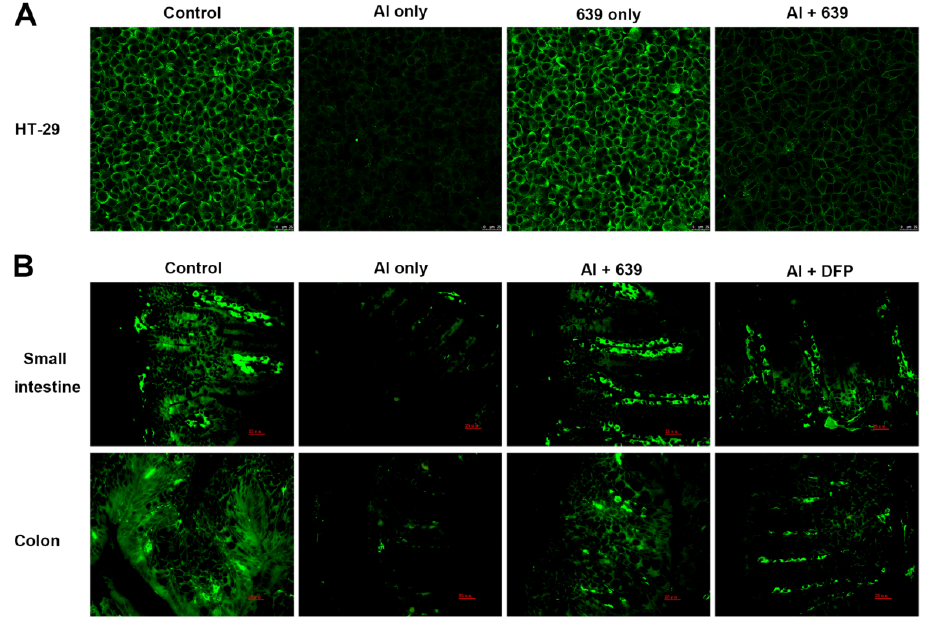
Figure 1. Effects of L. plantarum CCFM639 on Al ‐ induced alterations of tight junction protein ZO ‐ 1: in vitro ( A ); and in vivo ( B ). The ZO ‐ 1 levels in HT ‐ 29 cell (therapy assay) and intestine of mice (intervention assay) were observed with confocal microscopy and stained by Alexa Fluor 488 (green).